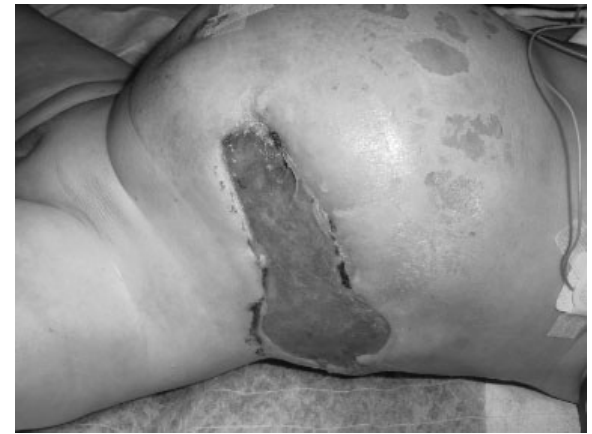
Fig. 2 Day postoperative